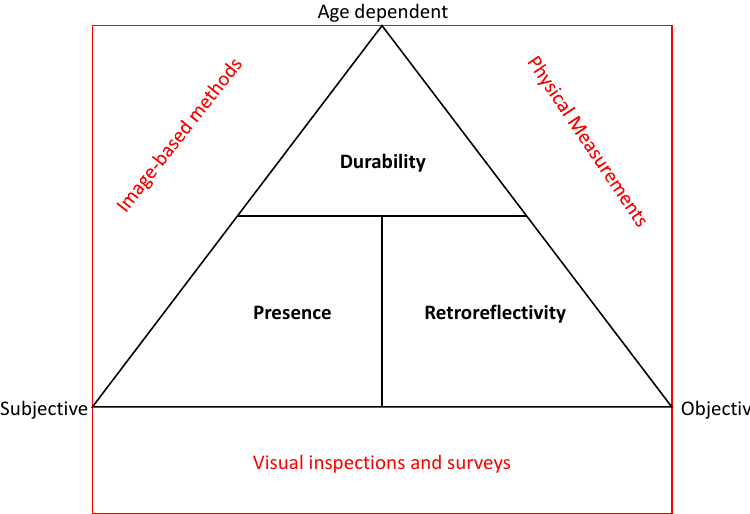
Figure 3. The primary pavement-marking performance measures.